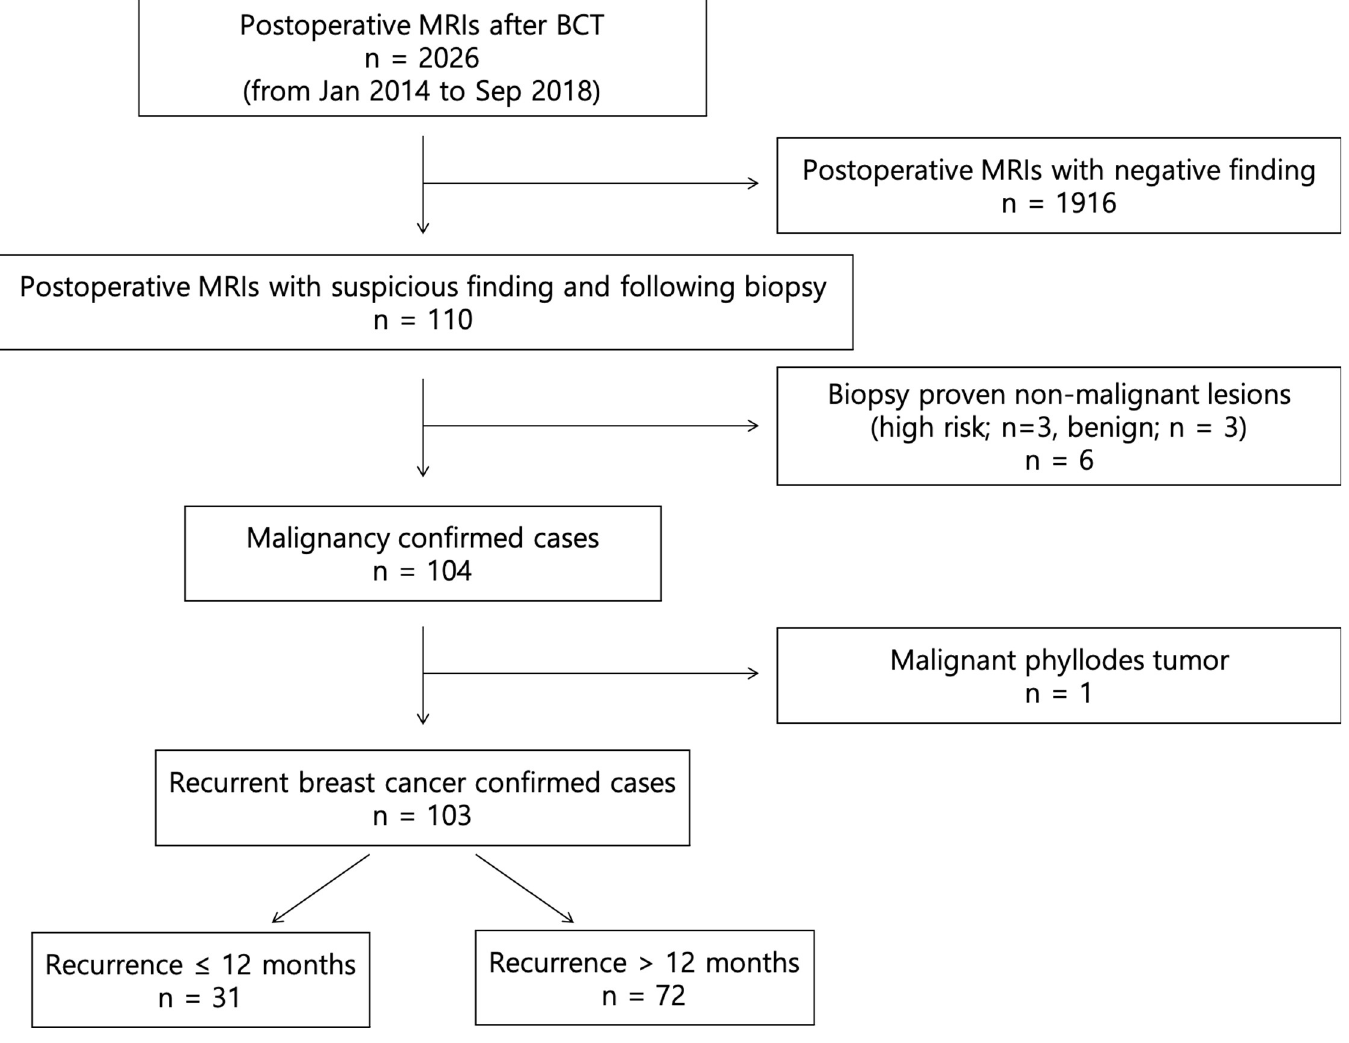
Fig 1. Inclusion and exclusion criteria for patient